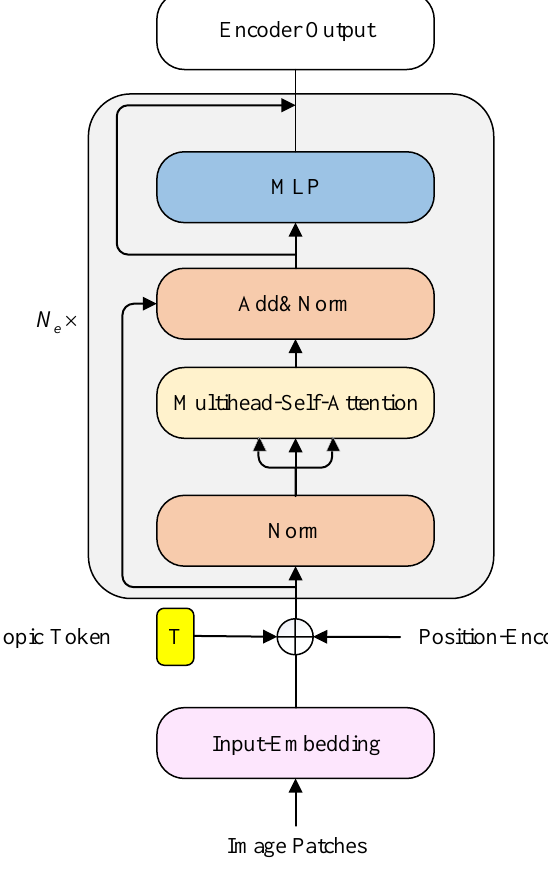
Figure 4. The structure of topic